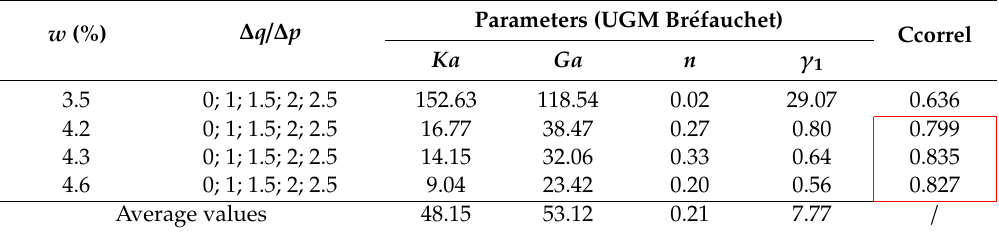
Table 5. Parameter optimization of Equations (8)–(11) for UGM Br é fauchet with γ 1 . w (%) ∆ q / ∆